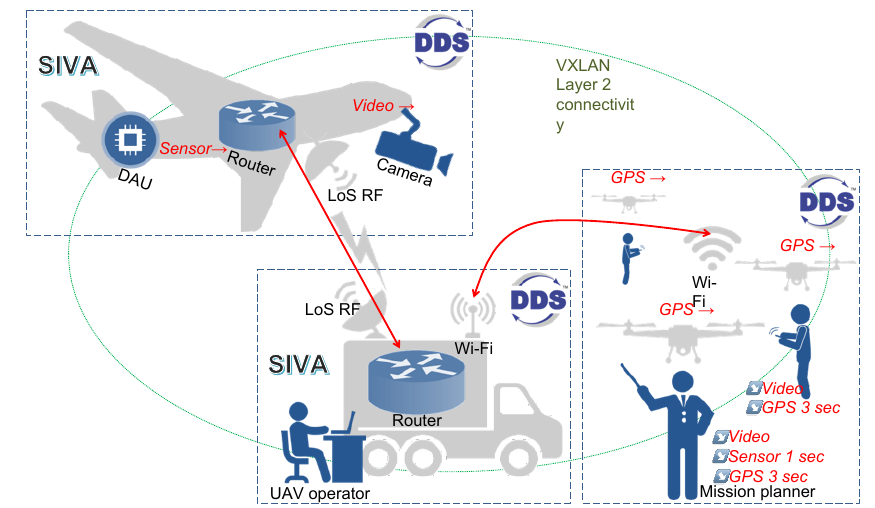
Figure 2. Validation testbed including tactical UAV, GCS and small